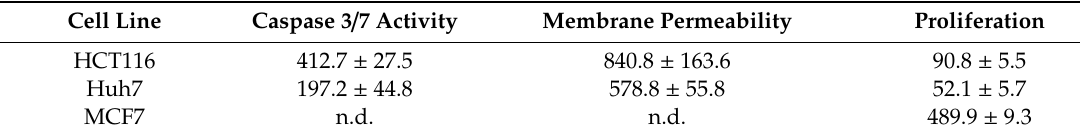
Figure 1. Live cell microscopy-based analysis of thioA-induced cell death and anti-proliferative activity. HCT116, Huh7, and MCF7 cells were stained for caspase 3/7 activity ( A – C ) and cell membrane permeability ( D – F ) and monitored in an IncuCyte S3 system during thioA or vehicle control treatment over 88 h. Cell confluency was monitored in parallel ( G – I ). Fluorescent signals from apoptotic and dead cells were normalized to cell confluency ( A – F ). Cell confluency was normalized to time point 0 h ( G – I ). Statistical analysis was performed for the last acquired time point using one-way ANOVA followed by Bonferroni’s post-hoc analysis. n = 3 (quadruplicates). Table 2. IC 50 values (nM) ± SEM of thioA against HCT116, Huh7, and MCF7 tumor cell lines based on caspase 3 / 7 activity, membrane permeability, and cell confluency measured by automated microscopy; calculated for 48 h